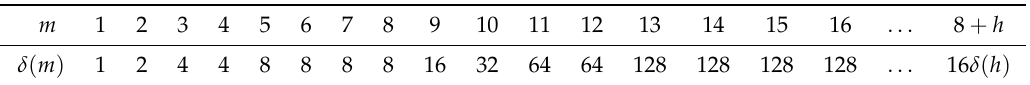
Table 2. Clifford systems.